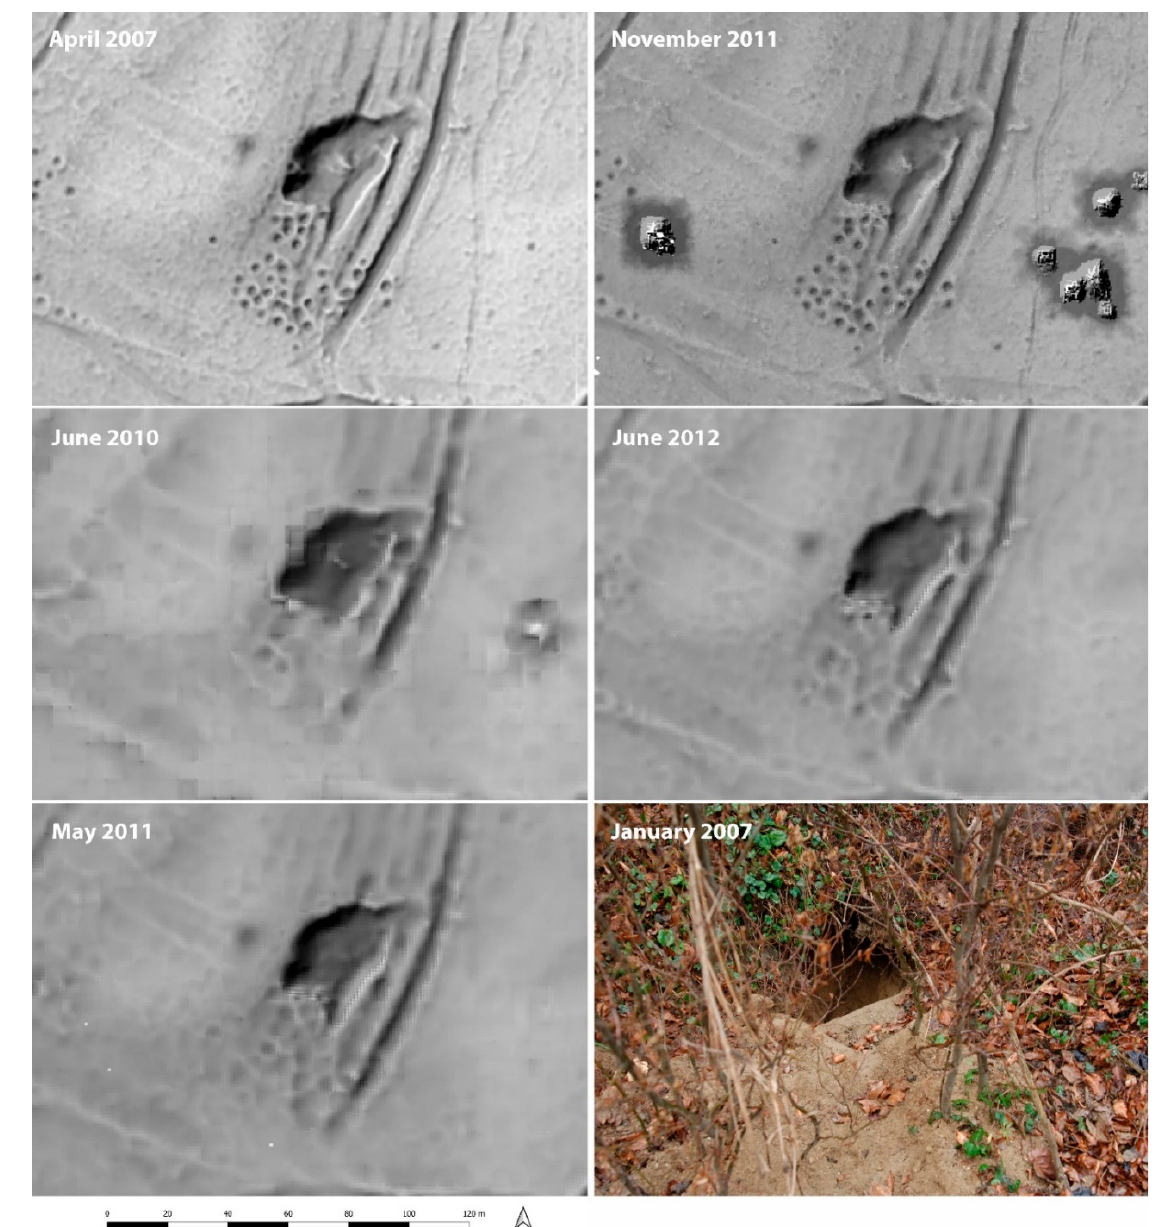
Figure 21. Sub-sample of Area 4. All visualizations are a combination of positive openness (with colour gradient black to white, stretch to min–max, min. 1.41–max. 1.58) and hillshade. The photograph ( lower right image ) shows the area from January 2007 (photograph by M.